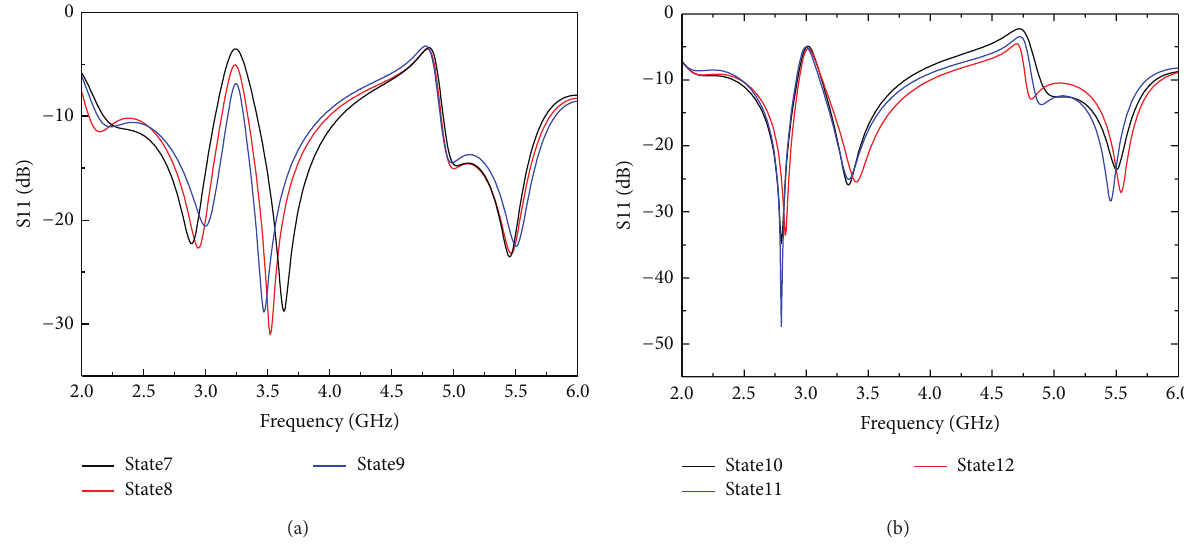
Figure 11: Effect of varying parameters on the amplitude and bandwidth of the notched bands: (a) length of the slot 𝑠1 (state7: 𝐿1 = 8.5 mm, 𝐿2 = 4.9mm, 𝐿3 = 11.5 mm, and 𝑊1 = 0.5 mm; state8: 𝐿1 = 8.5 mm, 𝐿2 = 4.7 mm, 𝐿3 = 10.5 mm, and 𝑊1 = 0.3 mm; state9: 𝐿1 = 9mm, 𝐿2 = 4.3 mm, 𝐿3 = 10mm, and 𝑊1 = 0.3 mm); (b) length of slot 𝑠2 (state10: 𝐿5 = 6.6 mm, 𝐿6 = 2.5 mm, 𝐿7 = 10mm, and 𝑊2 = 0.5 mm; state11: 𝐿5 = 7 mm, 𝐿6 = 2.8 mm, 𝐿7 = 8.5 mm, and 𝑊2 = 0.5 mm; state12: 𝐿5 = 6.8 mm, 𝐿6 = 2.8 mm, 𝐿7 = 7.5mm, and 𝑊2 = 0.4